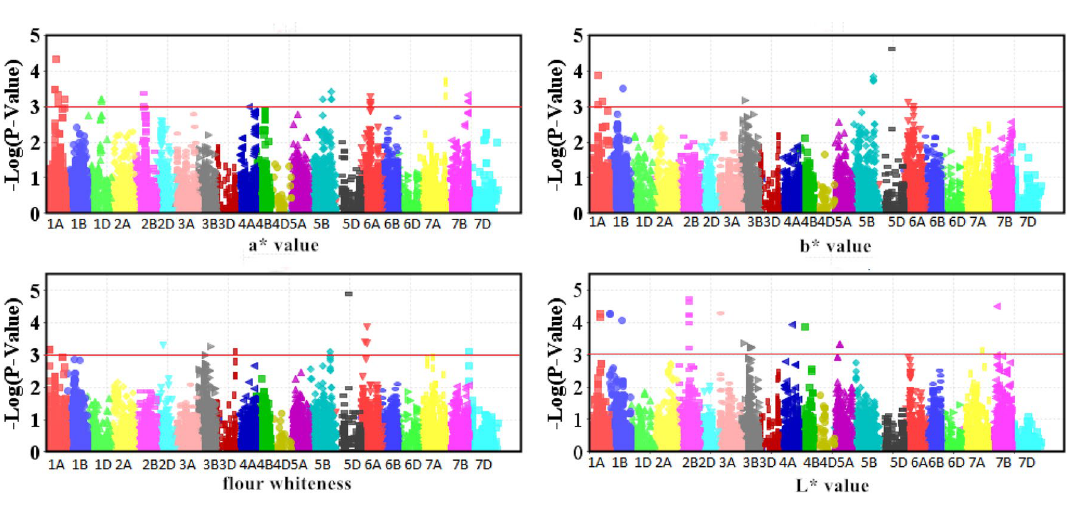
Figure 1. Manhattan plot of flour whiteness and flour